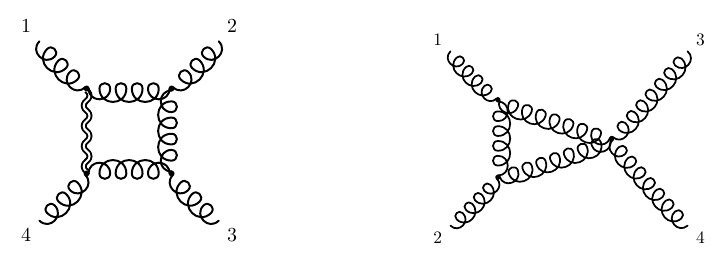
Figure 12 . At order κ 2 g 2 the four-gluon EYM amplitude at one loop has a single- and a double-trace sector. The single-trace sector in (5.4) is exclusively furnished by the box diagrams in the left panel with one propagator of the gravity multiplet (double wavy line). The tree diagrams in its partial-fraction decomposition correspond to forward limits in different particles, see figure 4 for their YM + φ 3 analogue. The double-trace sector in (5.7) of the maximally supersymmetric four-gluon amplitude is built from the triangle diagrams in the right panel. All graphs in this figure and later ones do not represent Feynman diagrams but instead illustrate the propagator structure of the maximally supersymmetric loop